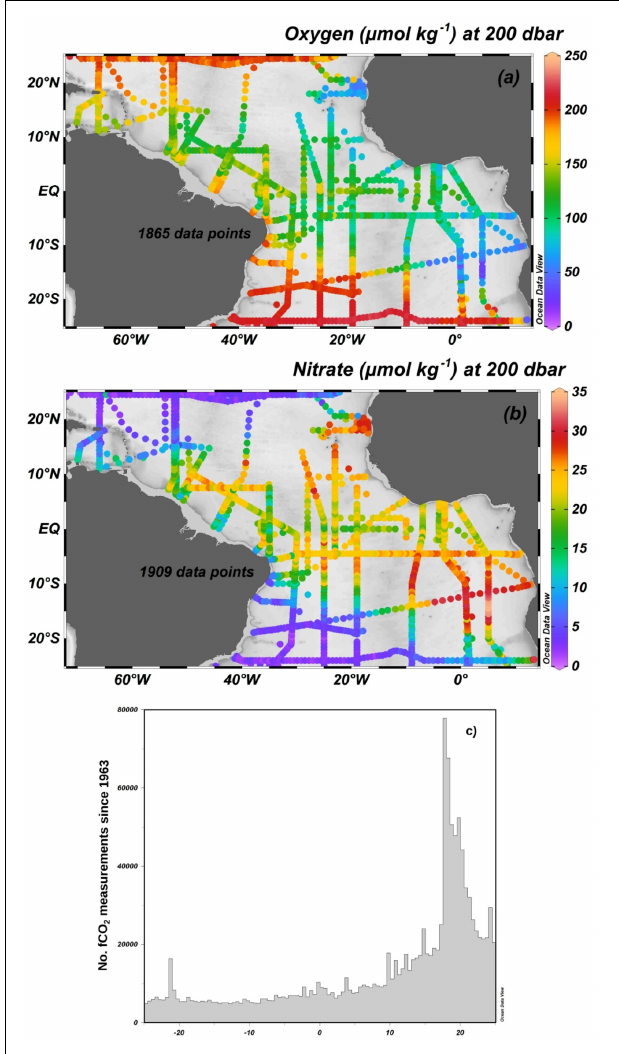
FIGURE 12 | Number of historical in situ measurements of (a) oxygen and (b) nitrate at 200 dbar acquired during repeat hydrographic cruises (GLODAP v2 data product, Olsen et al., 2016). Note that the color scales are different in panels (a,b) . (c) Total number of surface CO 2 fugacity ( f CO 2 ) measurements since 1963 across all longitudes in the tropical Atlantic for each 0.5 ◦ latitude bin (SOCATv6, Bakker et al., 2016).